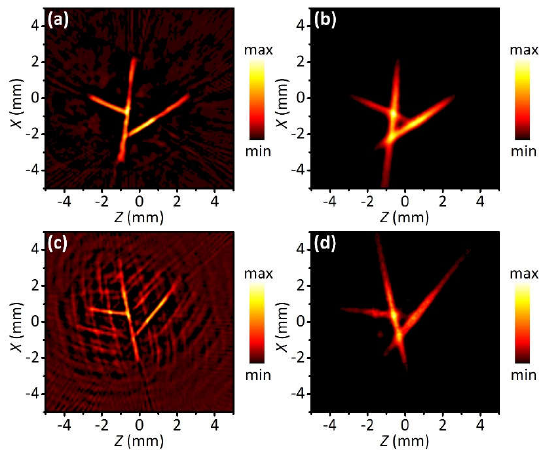
Figure 5. Reconstructed images of the vessel shape source in the ROI. Reconstructed image of the sample without the beaker ( a ) by the DAS beamforming method and ( b ) by the proposed matrix filtering method. Reconstructed image of the sample with the beaker ( c ) by the DAS beamforming method and ( d ) by the proposed matrix filtering